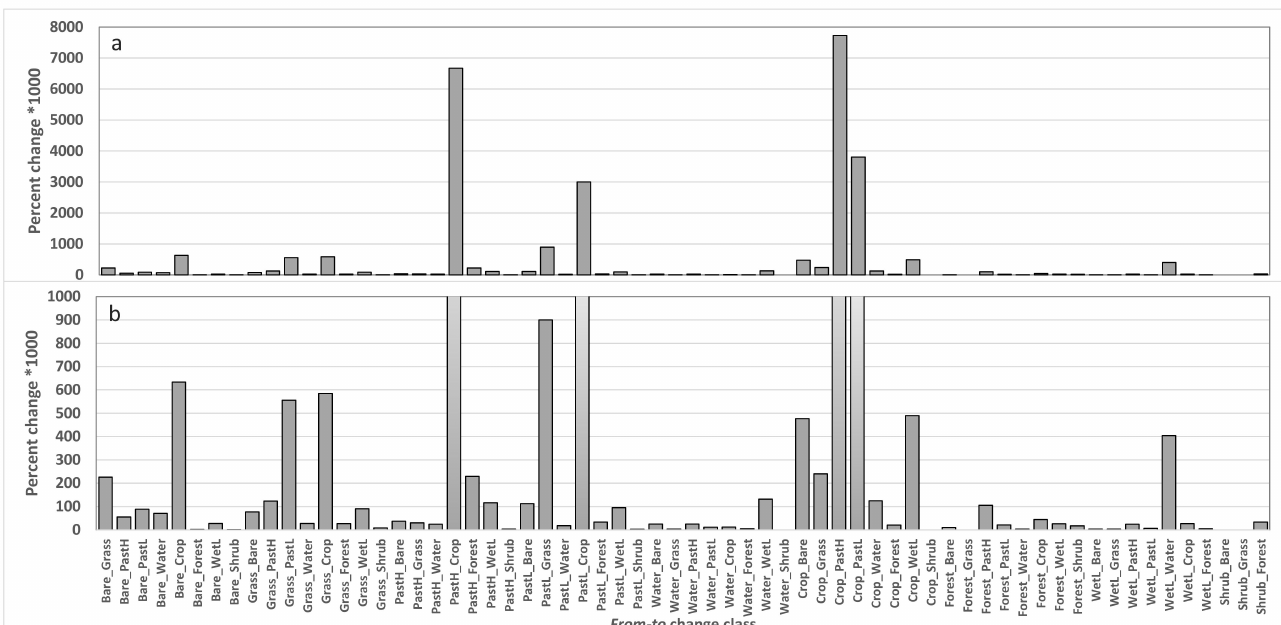
Figure 7. Percent change detected by change class across study sites for the full y-axis range in ( a ) and a smaller range in ( b ). The wetland class is denoted as WetL and the high-biomass and low-biomass pasture classes as PastH and PastL